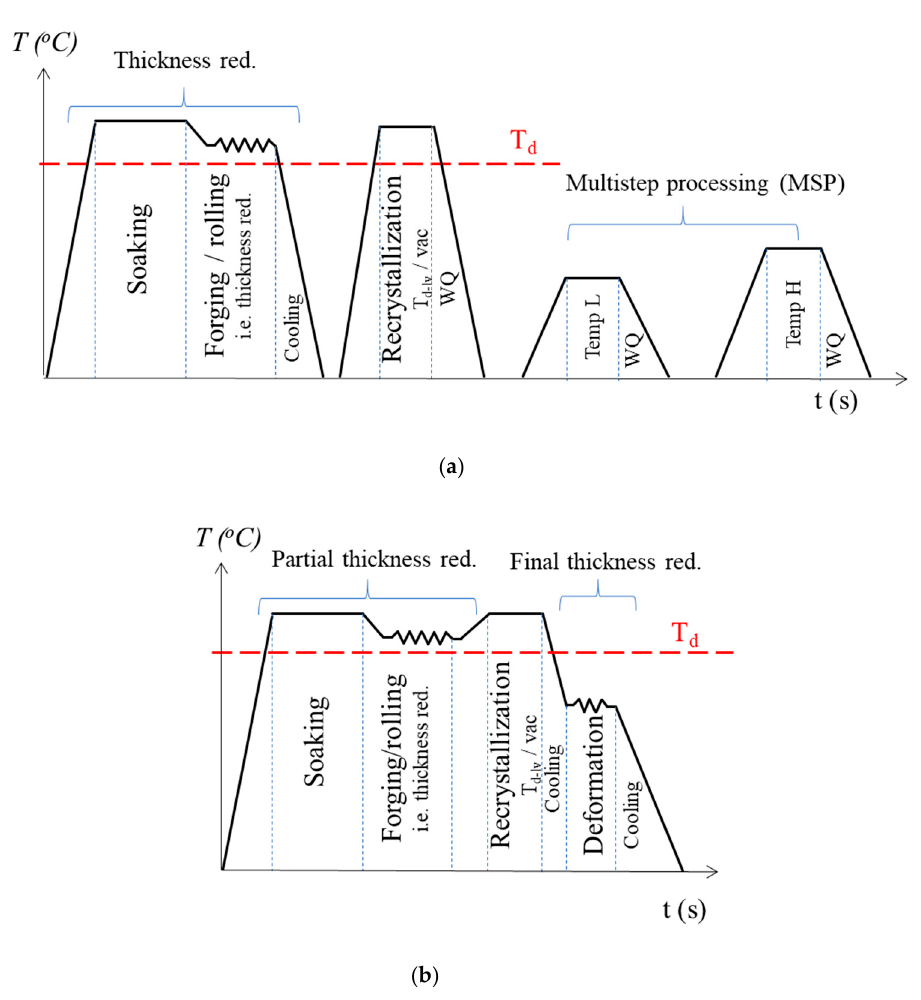
Figure 2. Processing of HiperFer steel via ( a ) standard multistep processing (MSP) and ( b ) integrated thermomechanical processing (TMP). T d : Dissolution temperature of the Laves phase.